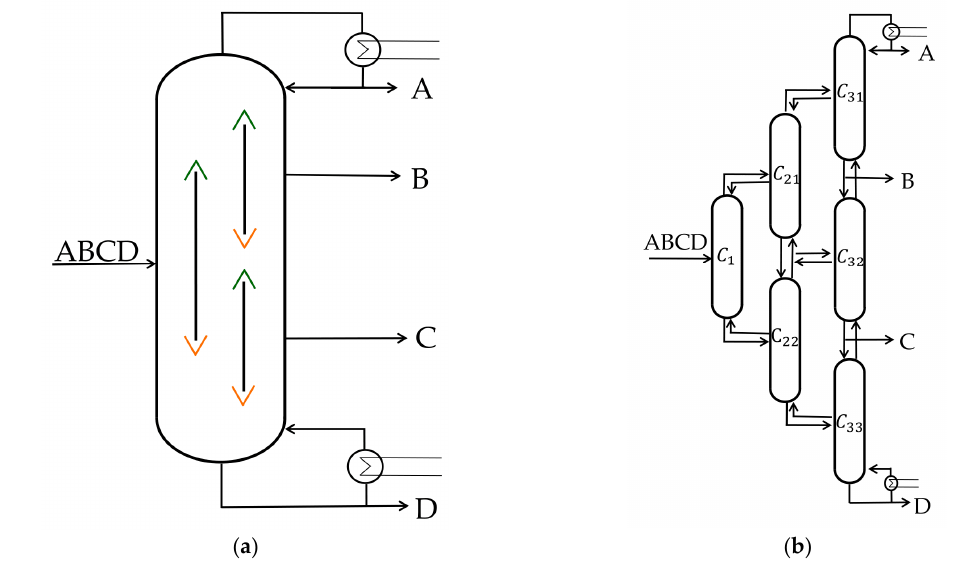
Figure 1. ( a ) Four product Dividing Wall Column with three dividing walls. Green: Liquid splits; Orange: Vapor splits; ( b ) corresponding Petlyuk sequence.